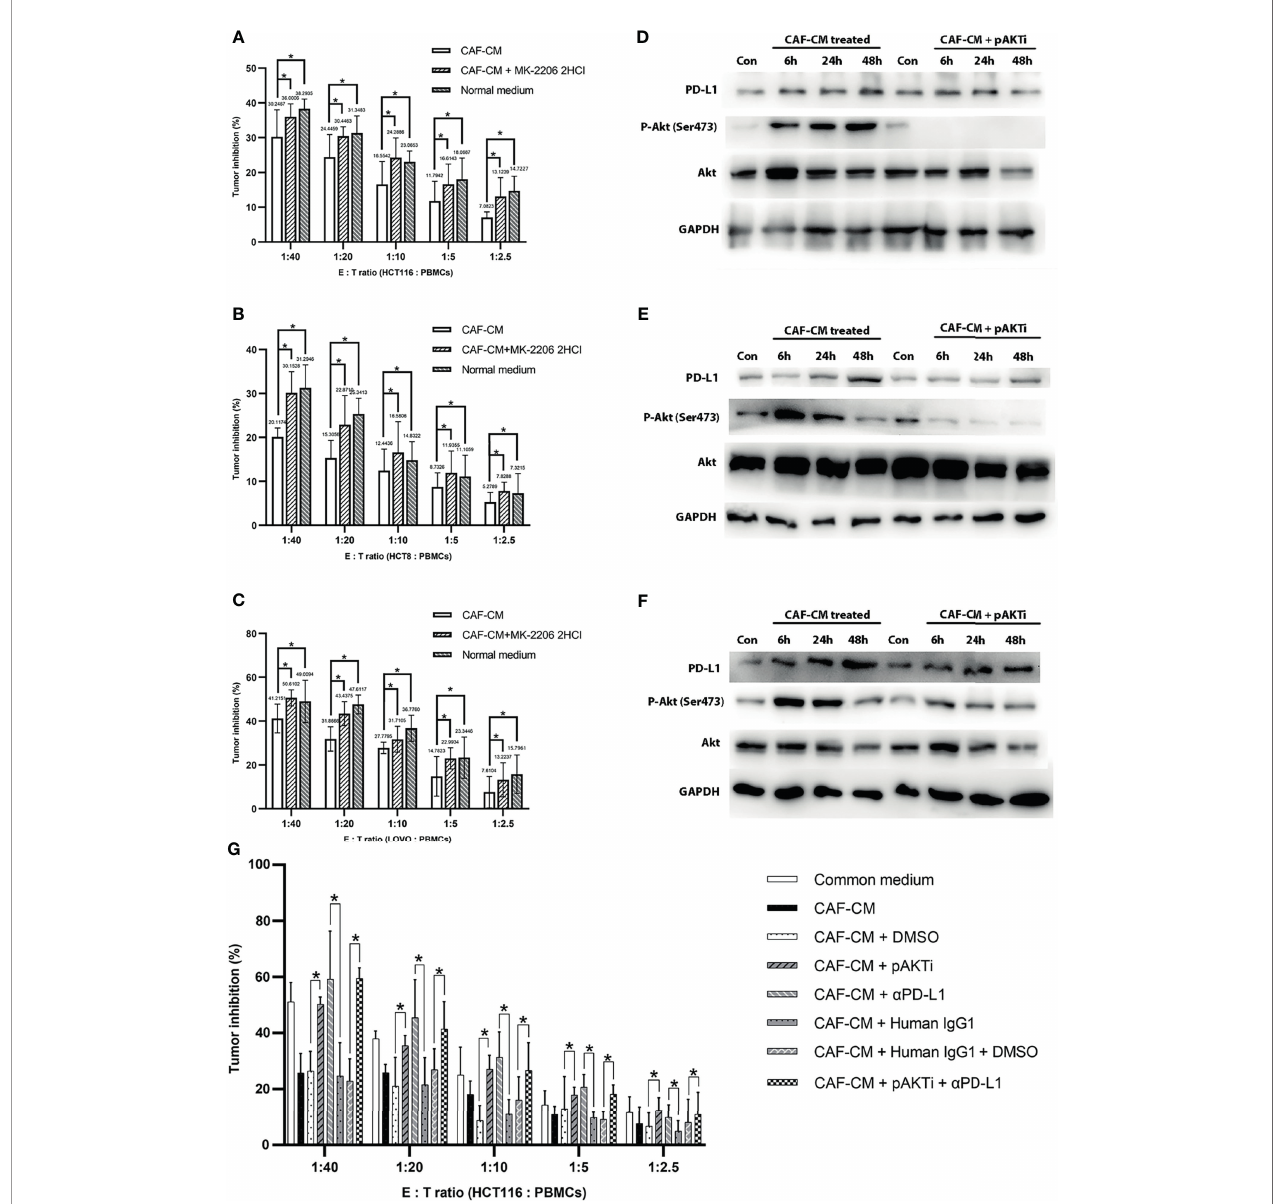
FIGURE 3 | CAFs upregulatedPD-L1inCRC cellsthrough Aktphosphorylation and promoted immune escape. (A – C) The killing rateof HCT116, HCT8 andLOVO cells cultured with CAF-CM was signi fi cant lower than these cells cultured with CAF-CM + pAKTi ornormal medium after 72h. (A) HCT116; (B) HCT8; (C) LOVO. (D – F) The upregulation ofPD-L1expression onHCT116 (D) , HCT8 (E) andLOVO (F) was weakened compared with control groupsafter pAKTi (MK-2206 2HCI) was added. (G) After blockingofPD-L1, the killing rate was signi fi cant higher inCAF-CM+ a PD-L1groupcompared with CAF-CM + human IgG1 group.When both AKTand PD-L1were blocked,the killing rate was similar to the CAF-CM+ human IgG1 + DMSO group. There was nosigni fi cant difference between the CAF-CM + pAKTi + a PD-L1 group with CAF-CM+ pAKTi group or CAF-CM + a PD-L1group. Each group was replicatedin 6 wells. *P < 0.05. Conmeanscellstreated with normal